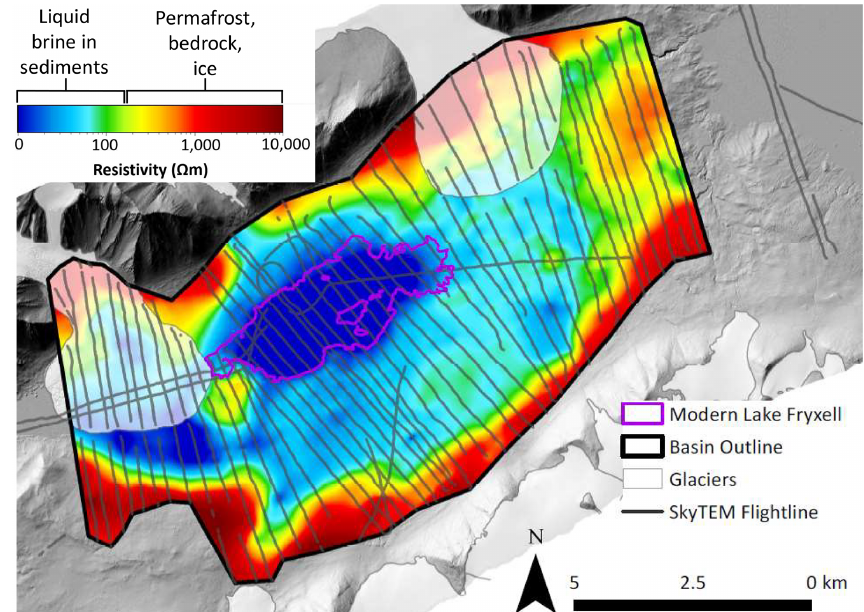
Figure 6. Mean resistivity map of constant elevation ( − 100ma.s.l., 5m thick slice) generated from SkyTEM data. Flight lines are shown as a transparent gray, which indicate the flight path of the helicopter as it flew over Fryxell basin in 2011. Each flight line is made up of individual nodes spaced ∼ 25m apart. The mean resistivity map was generated in Aarhus Workbench and interpolates between nodes to create a 3D resistivity inversion model. This figure represents just one 5m thick slice of the 3D inversion taken at 100m below sea level (in the subsurface). The outline of modern Lake Fryxell is shown in pink and glaciers as transparent polygons. The thick black polygon (basin outline) represents the extent of reliable data, which was truncated at the edge of each flight line to reduce extrapolation artifacts. The digital elevation model (DEM) used for the background (1m resolution) is from a 2014–15 lidar survey, accessed via OpenTopography (Fountain et al.,